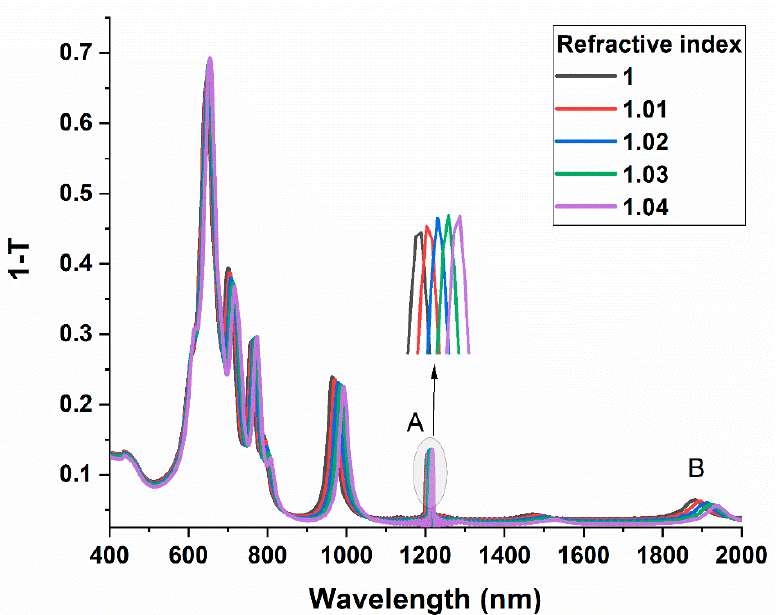
Figure 4. Absorption spectra of Au ND-G flakes hybrid nanostructure at different refractive index of sensing medium.